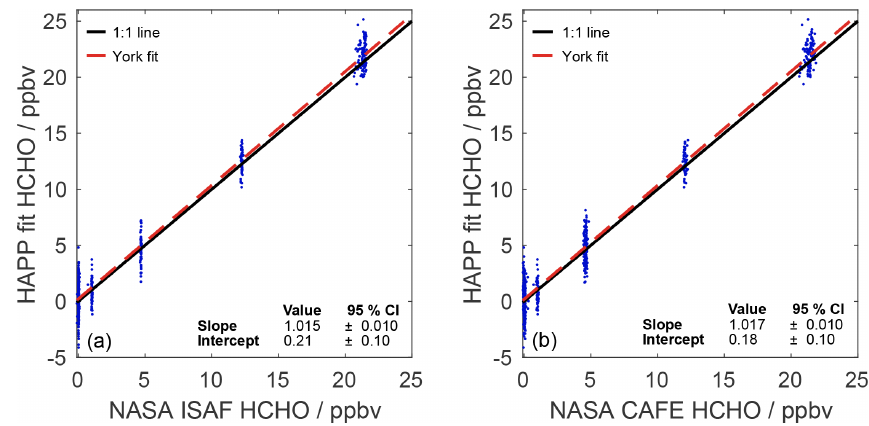
Figure 4. Correlation plots between the HAPP HDO fit and two NASA LIF instruments: (a) NASA ISAF ( R 2 = 0 . 979) and (b) NASA CAFE ( R 2 = 0 . 976). A time series plot for the stepped intercomparison performed at NASA Goddard is located in the Supplement (Fig.